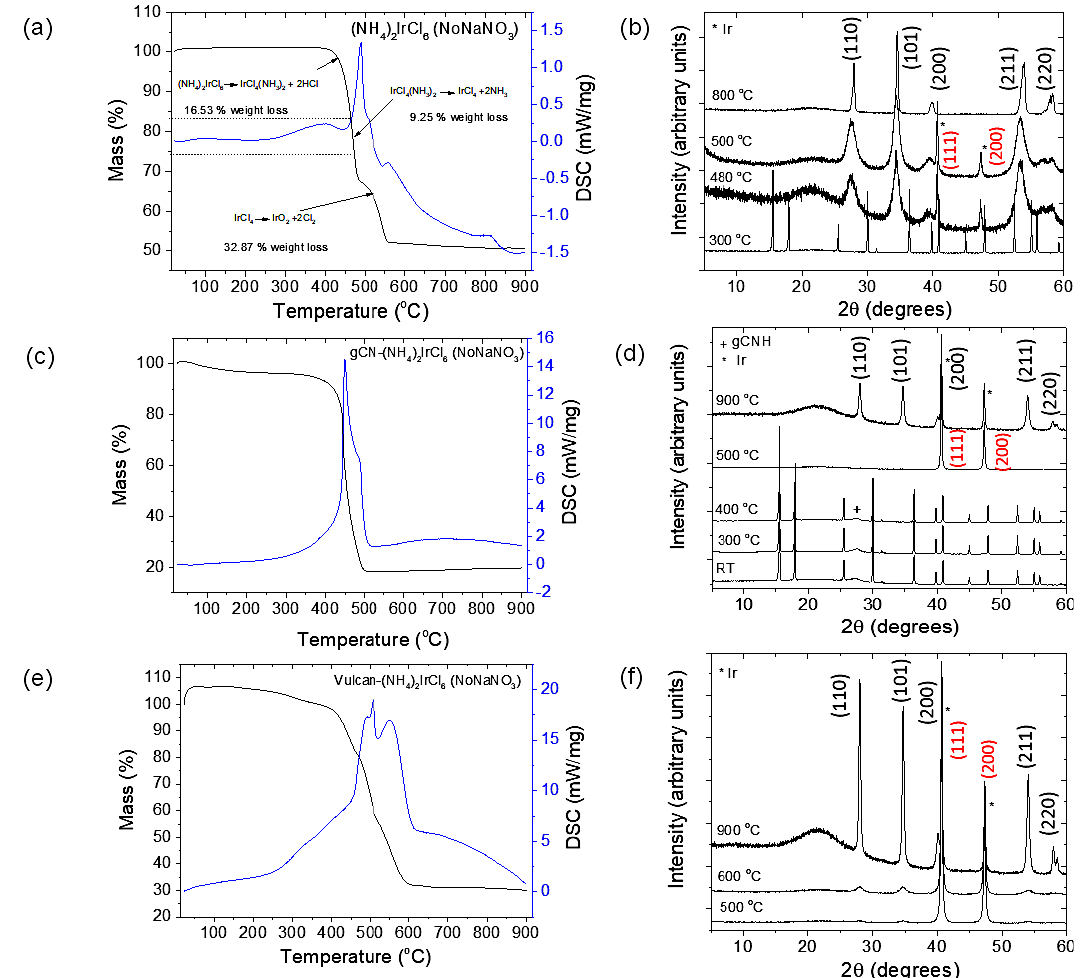
Figure 3. Left : TGA/DSC traces of ( a ) (NH 4 )Ir 2 Cl 6 , ( c ) gCNH-(NH 4 ) 2 IrCl 6 , ( e ) Vulcan-(NH 4 ) 2 IrCl 6 conducted in air at 5 °C min −1 heating rate. Right: the XRD of products of TGA analysis at different temperatures for ( b ) (NH 4 ) 2 IrCl 6 , ( d ) gCNH-(NH 4 ) 2 IrCl 6 and ( f ) Vulcan-(NH 4 ) 2 IrCl 6 . Peaks due to metallic Ir are indexed in red.